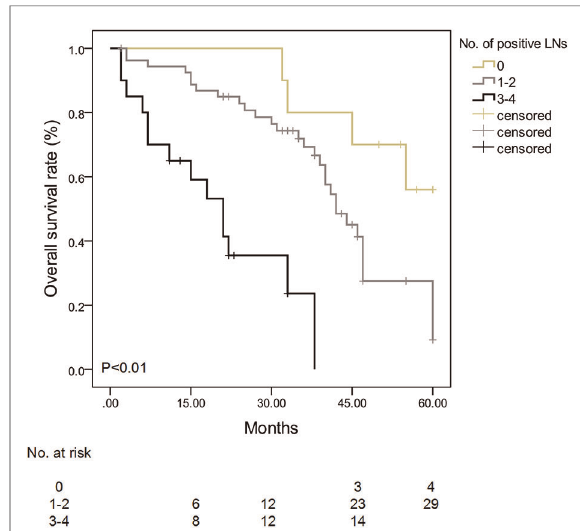
FIGURE 1 Survival curve strati fi ed by the number of positive #13, #17, #12, and #8 lymph nodes in patients with ampullary adenocarcinoma. Patients with 3 – 4 positive nodes among #13, #17, #12, and #8 LNs had a lower survival rate than patients with 0 or 1 – 2 nodes ( P <0.01).